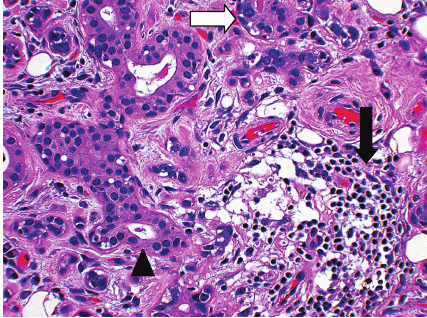
Figure 5: Amifostine (HE, Original magnification × 28). Acini show atrophy (white arrow) with duct preservation (arrowhead), and fibrosis and focal inflammation (black arrow).